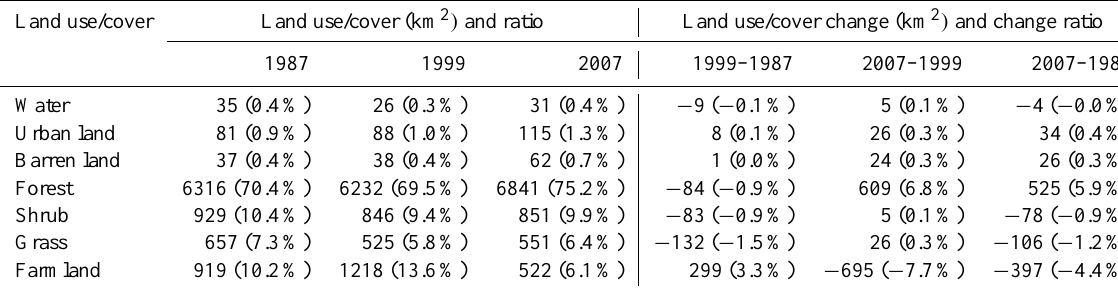
Table 1. Land use/cover type and change ratio during 1978–2007 in the Du catchment Land use/cover